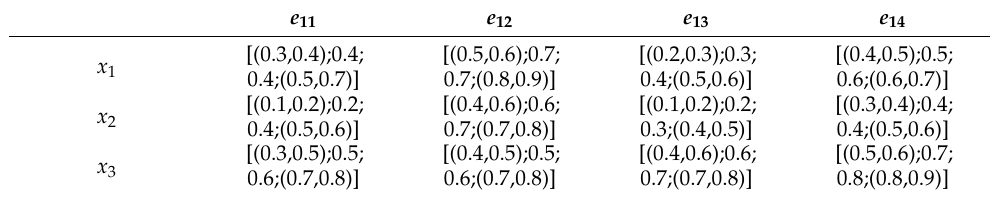
Table A6. The different risk evaluation values subordinated by influencing factors of B 1 at time t 2 .